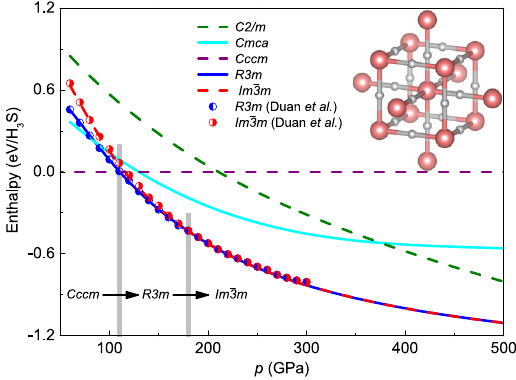
Figure 1. The influence of the pressure on the value of the enthalpy for selected crystal structures. The symbols represent the results obtained by Duan et al . 2 . Moreover, the Im m 3 crystal structure assumed for H 3 S is included.